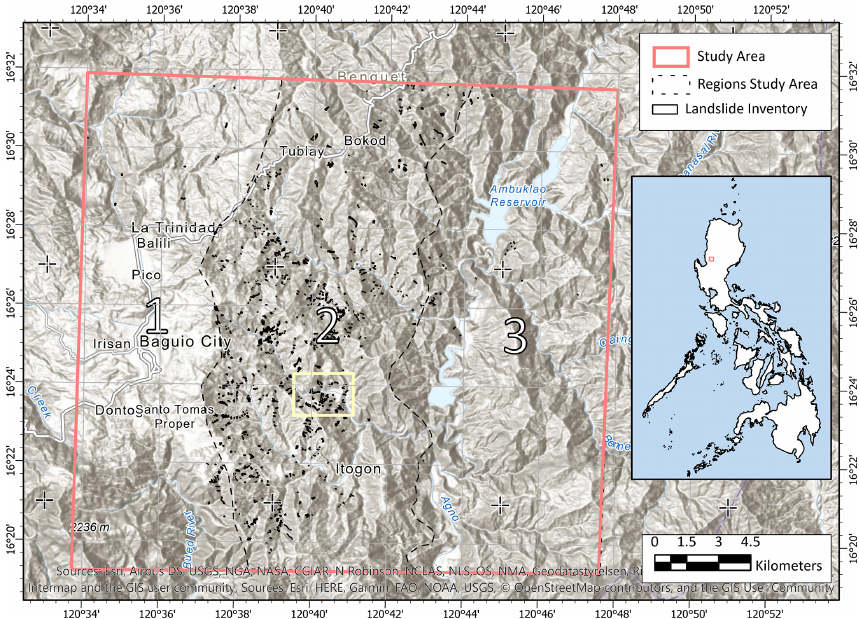
Figure 1. Landslide inventory. The area affected by 1101 landslides triggered by Typhoon Mangkhut was mapped using polygons. Three regions of the study area are distinguished (see text in Sect. 2.1). The yellow area is referred in Fig. 5. Inset, location of the study area within the Philippines, in the province of Benguet (Luzon). © OpenStreetMap contributors 2021. Distributed under a Creative Commons BY-SA License. Table 1. Average maximum and minimum monthly precipitation (from 1960 to 1990) in the different regions of the study area (see Fig.